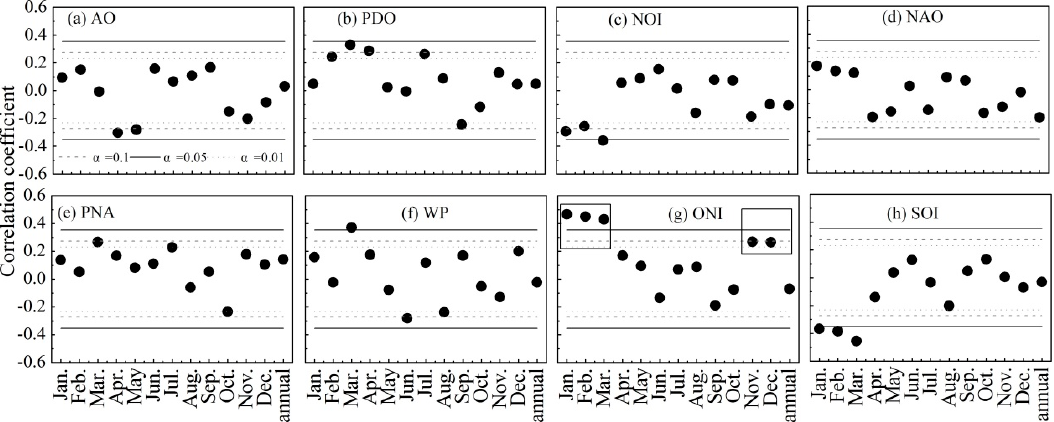
Figure 8. Pearson’s correlations between stream flow and atmospheric circulation index (AO, Arctic Oscillation ( a ); PDO, Pacific Decadal Oscillation ( b ); NOI, Northern Oscillation Index ( c ); NAO, North Atlantic Oscillation ( d ); PNA, Pacific North American Index ( e ); WP, Western Pacific Index ( f ); ONI, Oceanic Nino Index ( g ); SOI, Southern Oscillation Index ( h )). Except for ONI, Pacific Decadal Oscillation (PDO) was most closely related to stream flow (Figure 8b). PDO was positively correlated with monthly stream flow in March ( r = 0.244, P <